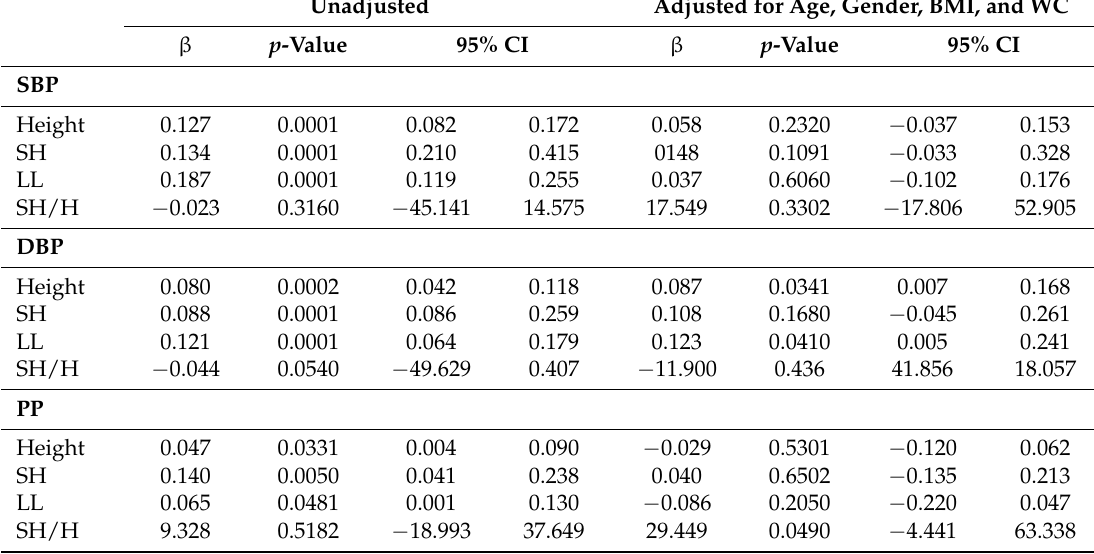
Table 2. Linear regression coefficients, p -value, and 95%confidence intervals for the association between sitting height (SH), SH to height ratio (SH/H), and blood pressures (BP) in Ellisras children age 5–12 years. Unadjusted Adjusted for Age, Gender, BMI, and